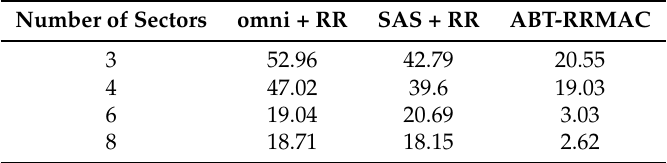
Table 2. Energy consumption: standard deviation vs. the number of sectors.